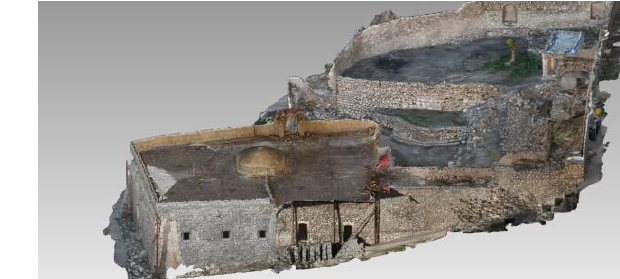
Figure 6. Example of the isometric view of the 3d model processed from the aerial data (DJI Phantom 4 with 4k camera Figure 7. Example of the textured model created from the photogrammetric data set with missing parts supplementation, view from the East